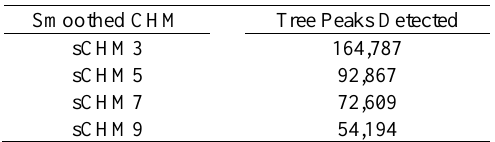
Table 2. Number of detected peaks in smooth CHM with varying degree of smoothness